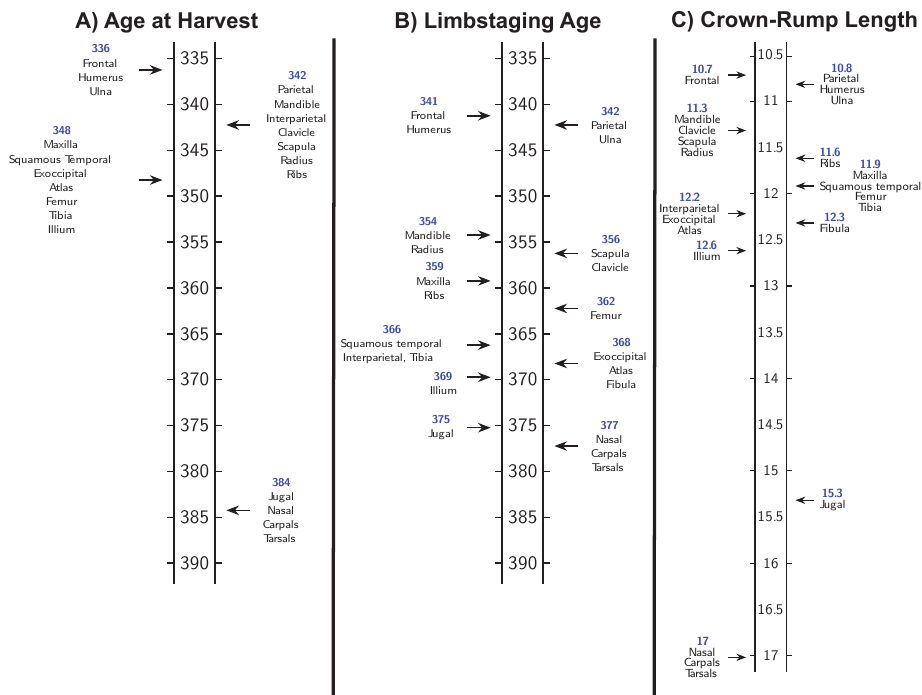
Figure 8. Timeline of ossification center appearance marked by mineralization of osteoid (marked by calcein staining) generated using C57BL/6-calcein mice ordered according to: ( A ) age at harvest; ( B ) limbstaging age; and ( C )